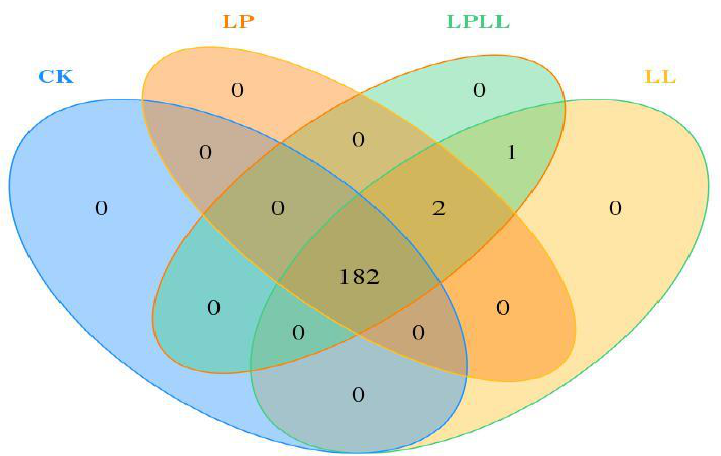
Figure 3. Veen Diagram of fermented sugarcane juice. CK: fresh sugarcane juice; LL: sugarcane juice with added HNK10; LP: sugarcane juice added with HNK21; LPLL: sugarcane juice treated with HNK10 + HNK21 was added.